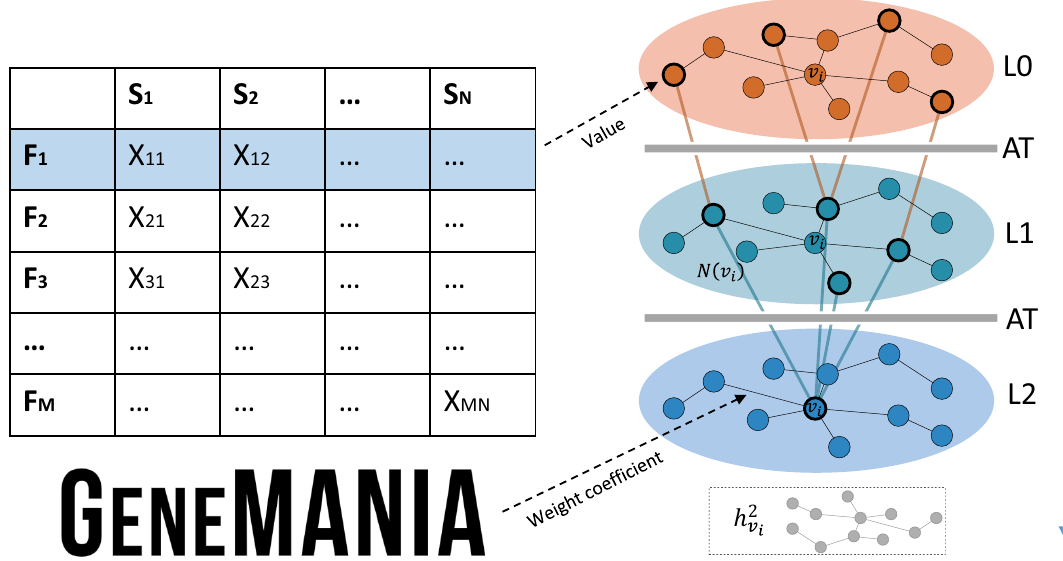
2 v i with global